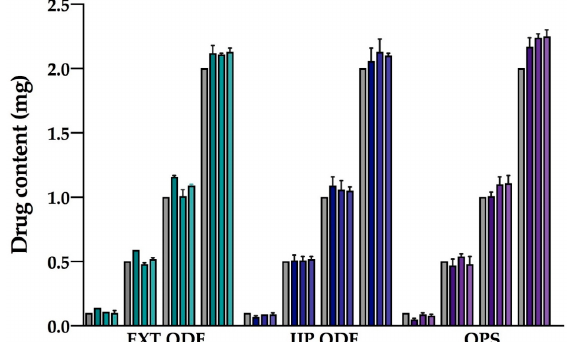
Figure 6. Drug content of the aimed doses of 0.1, 0.5, 1, and 2 mg for the prepared batches and various manufacturing techniques. Gray columns represent the target dose and the following columns represents batch 1, 2, and 3, respectively, for each manufacturing method. Data are presented as the average ± SD, n = 10.